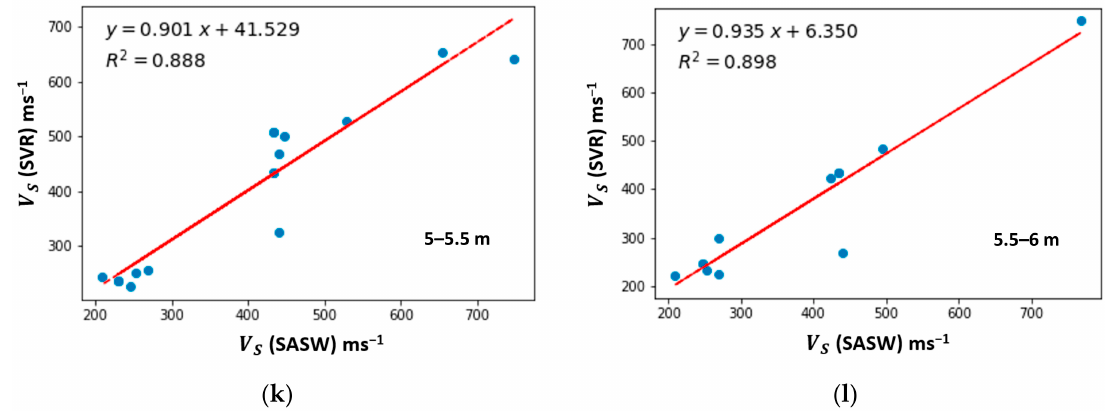
Figure 20. R2 between the SASW and SVR for ( a ) 0–0.5 m, ( b ) 0.5–1 m, ( c ) 1–1.5 m, ( d ) 1.5–2 m, ( e ) 2–2.5 m, ( f ) 2.5–3 m, ( g ) 3–3.5 m, ( h ) 3.5–4 m, ( i ) 4–4.5 m, ( j ) 4.5–5 m, ( k ) 5–5.5 m, and ( l ) 5.5–6 m of